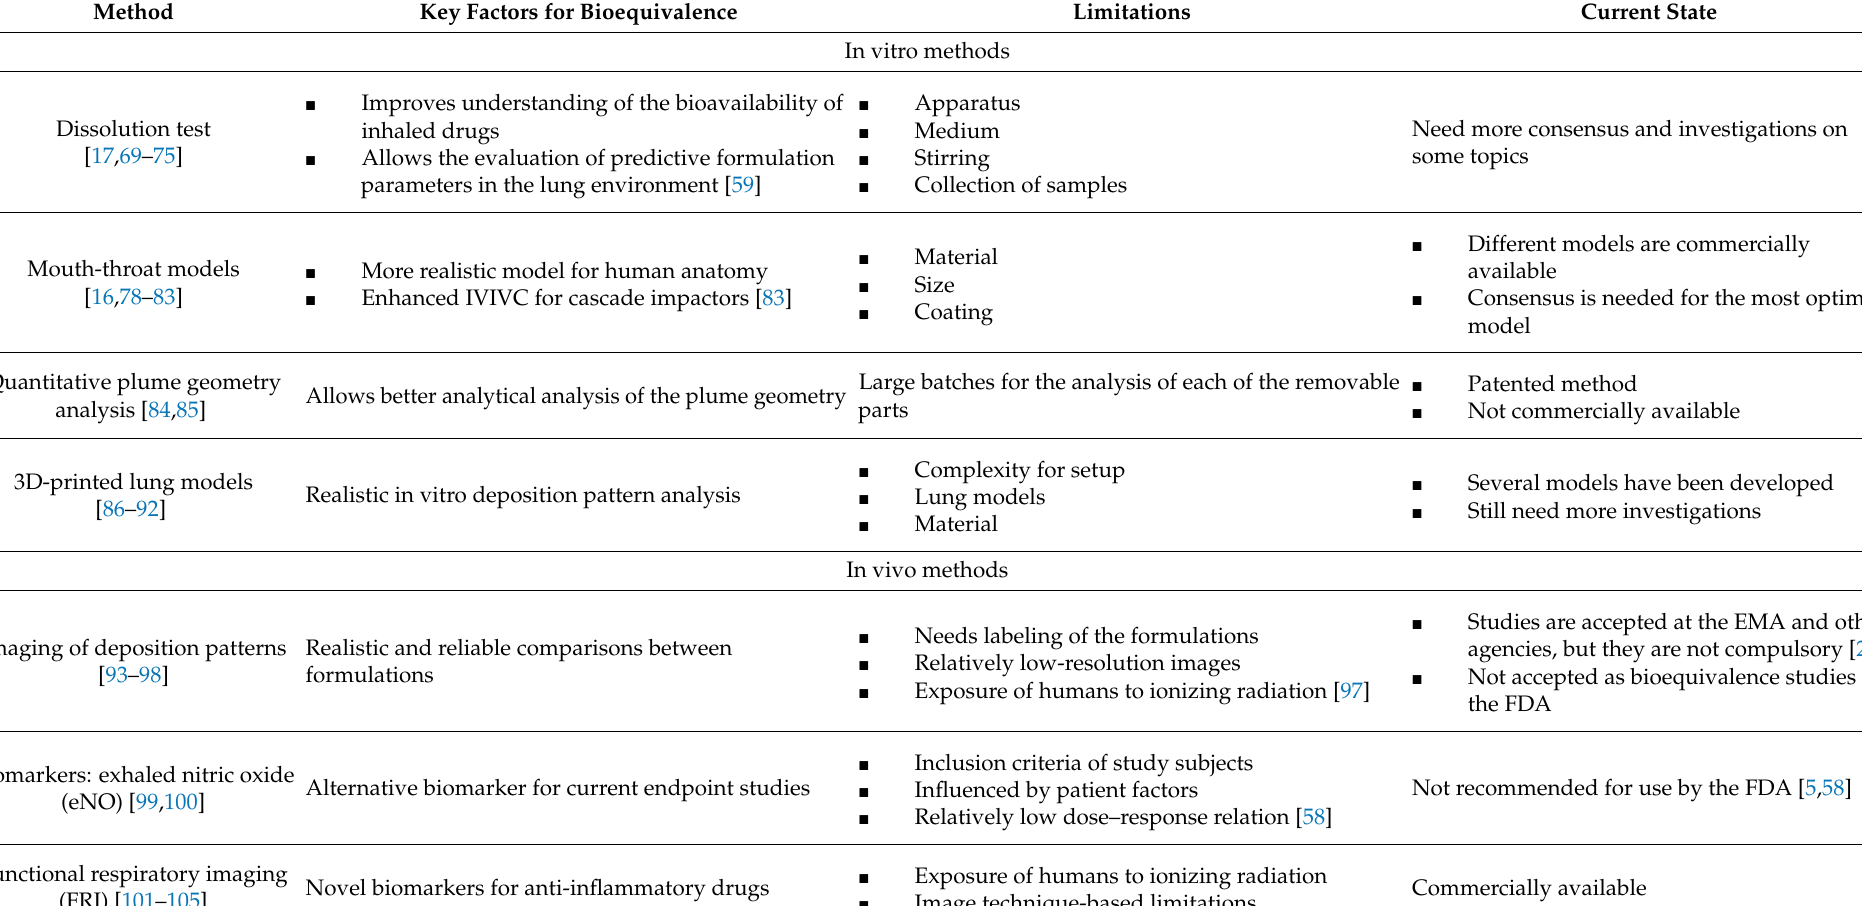
Table 2. Summary of alternative methods that can be used to establish bioequivalence of inhaled drugs. The current state of the methods is based on the latest publication of the regulation, scientific journals or presentations at